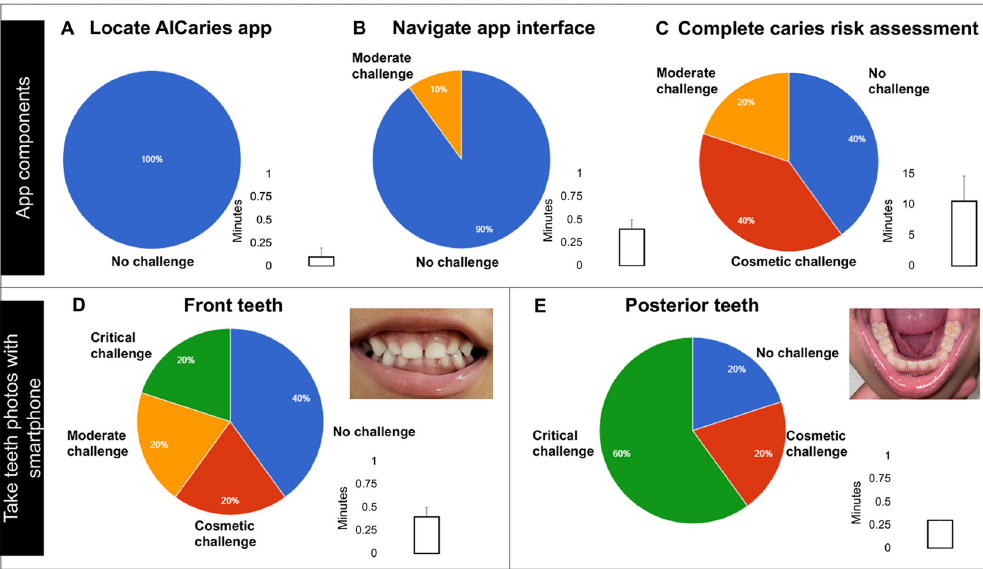
Fig 3. Task assessment and completion time in Step 1 moderated usability test. A total of 7 tasks was assessed. (A) All participating parents (n = 10) located the app icon on the study cellphone with no challenge. (B) 90% of them could navigate the app interface with no challenges. (C) In the caries risk assessment, 40% of the parents completed the risk assessment without challenges, 40% with cosmetic challenges, and 20% with moderate challenges. (D) For taking photos using the AICaries app, 40% of the parents took photos of their children’s front teeth without challenges. (E) Participating parents faced more challenges when taking photos of their children’s posterior teeth; only 20% could complete this task without challenges. Time spent on each task are shown in bar graph. In Fig 3D and 3E, the two photos (front teeth and posterior teeth) were taken by the mother of a 4-year-old child using the AICaries application, with no